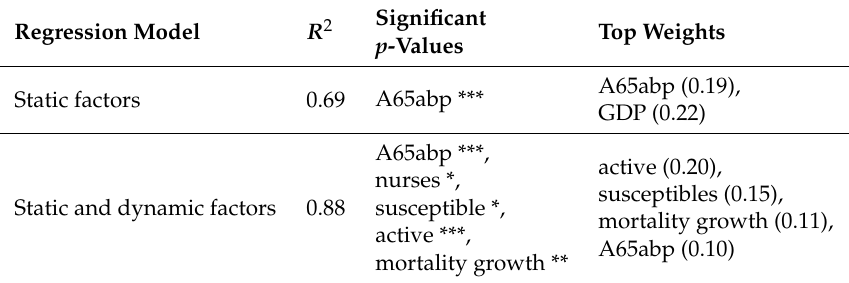
Table 2. Regression results for risk of mortality where for p -values “***” represents p < 0.001 m, “**” represents p < 0.01, and “*” represents p < 0.05.